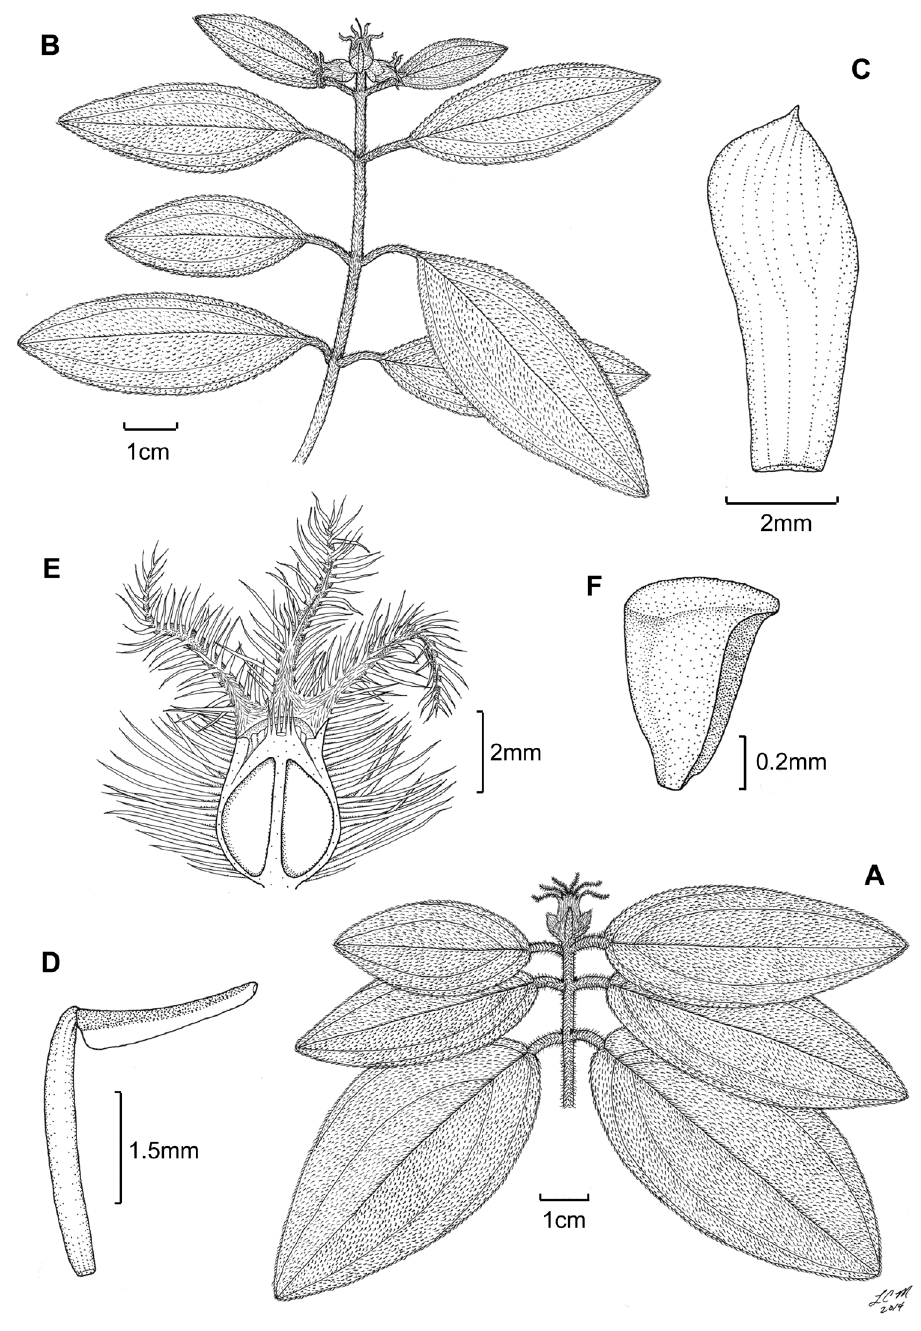
Figure 6. Illustration of Miconia cubacinerea ( A ) and M. tentaculicapitata ( B–F ). A Habit of M. cubaci- nerea from the type specimen ( Wright 2483 ) B habit of M. tentaculicapitata ( Ekman 14823 ) C petal ( Hioram 7218 ) D stamen ( Hioram 7218 ) E fruit longitudinal section ( Hioram 7218 ), and F seed ( León LS-12337